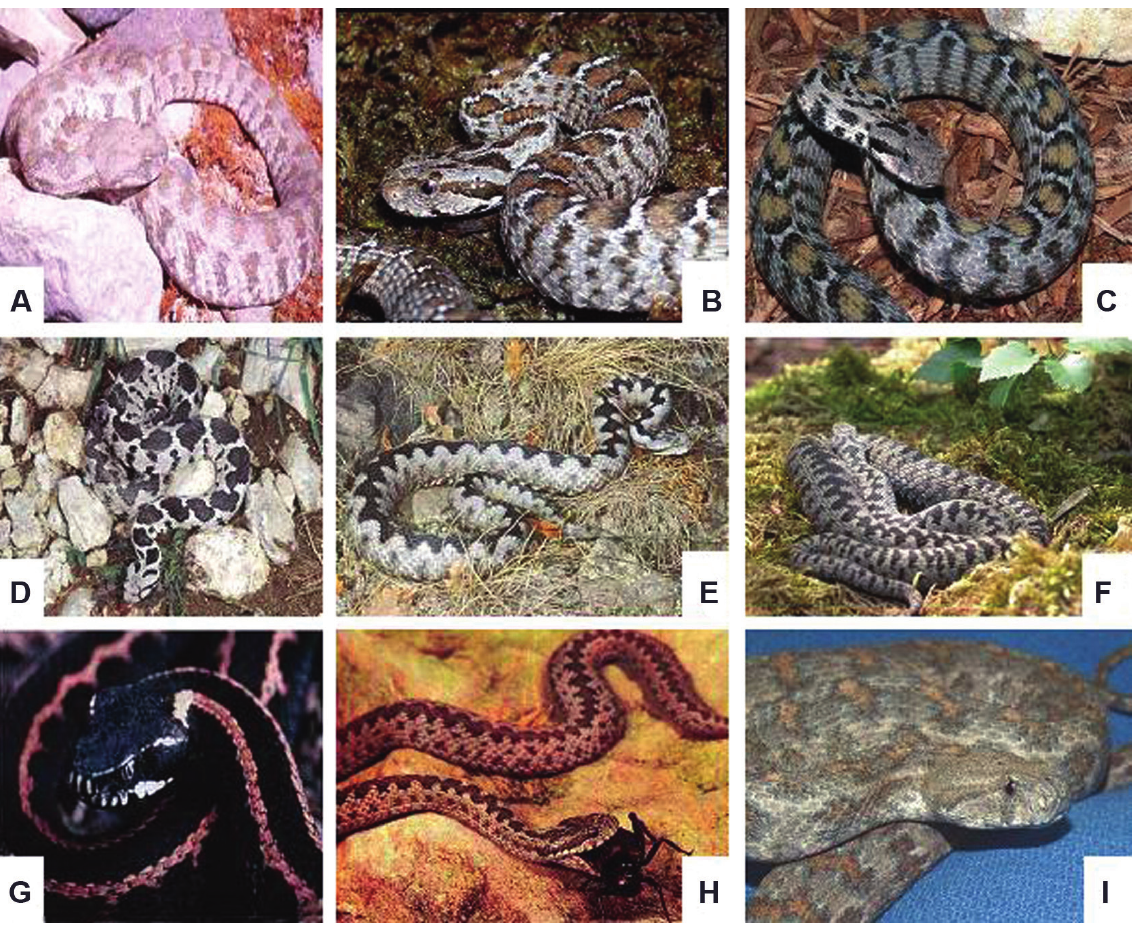
Figure 3. ( A ) Macrovipera lebetina, ( B ) Montivipera albizona, ( C ) Montivipera wagneri, ( D ) Montivipera xanthina, ( E ) Vipera ammodytes, ( F ) Vipera barani, ( G ) Vipera kaznakovi, ( H ) Vipera anatolica (V. ursinii anatolica) , ( I ) Vipera pontica. M. lebetina and M. xanthina are the most common venomous snakes in south and southeastern Anatolia.